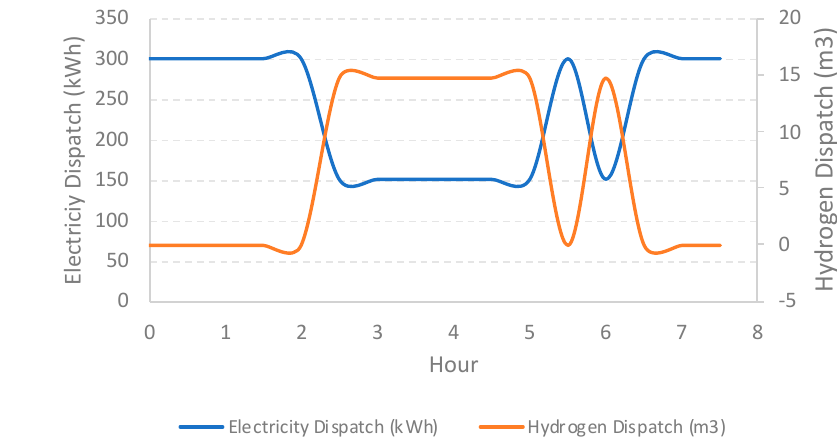
Figure 6. Example of dispatch logic over an 8 h period. ( a ) The opportunity cost for producing hydrogen or electricity. ( b ) Hydrogen or electricity modes dispatched in accordance with higher opportunity cost. This strategy ensures that electricity is sold only when profitable.